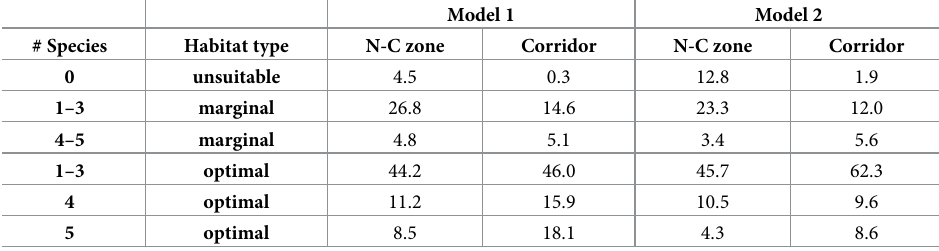
Table 6. The potential species richness (PSR) with habitat suitability subdivided into marginal and optimal habitat.